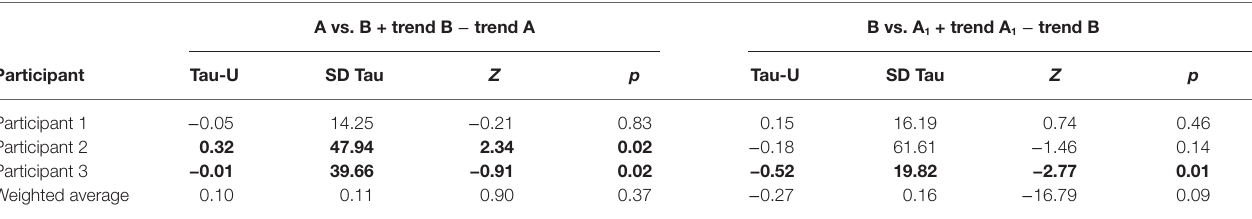
TABLE 2 | Tau-U calculations across phases for each participant.